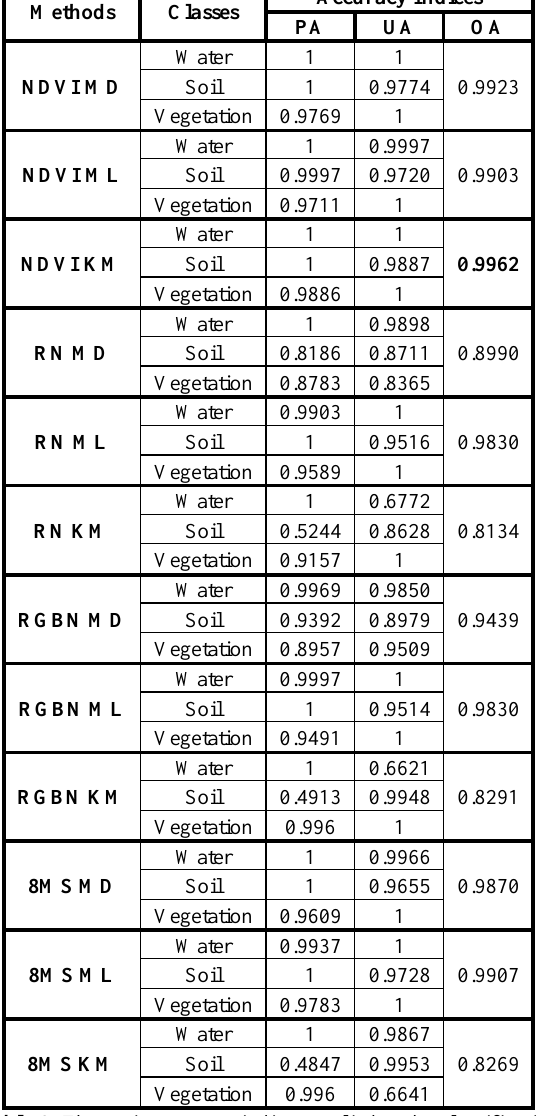
Table 2. Thematic accuracy indices applied to the classification methods.